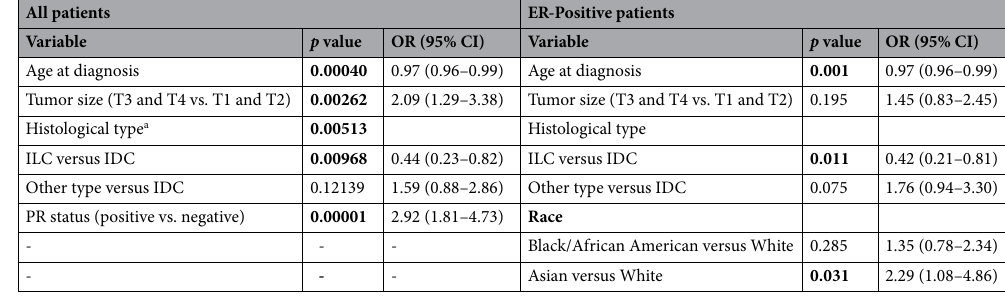
Table 2. Results of the multivariable logistic regression analysis. Significant p values are shown in bold. CI confidence interval, IDC invasive ductal carcinoma, ILC invasive lobular carcinoma, OR odds ratio, PR progesterone receptor. a Other category includes rare histological types, such as metaplastic and medullary